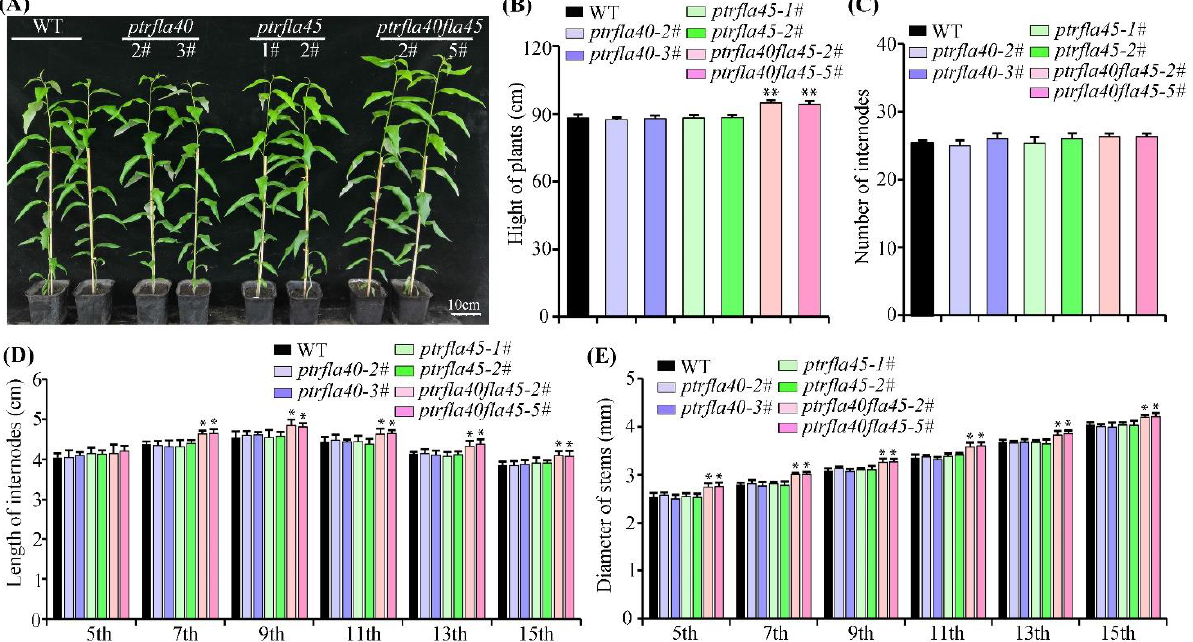
Figure 4. Phenotypes of the ptrfla40 , ptrfla45, and ptrfla40fla45 mutants. ( A ) Morphology of wild-type (WT) and mutants grown for 4 months in the greenhouse. ( B , C ) Plant height and internode number of wild-type, ptrfla40, ptrfla45 , and ptrfla40fla45 mutants. ( D , E ) Length and diameter of the 5th, 7th, 9th, 11th, 13th, and 15th stem internodes (starting from the morphological apex) in the WT and mutants. Data are means ± SD ( n = 3 ). Bar: 10cm. Student’s t -test: *, p < 0.05; **, p < 0.01.